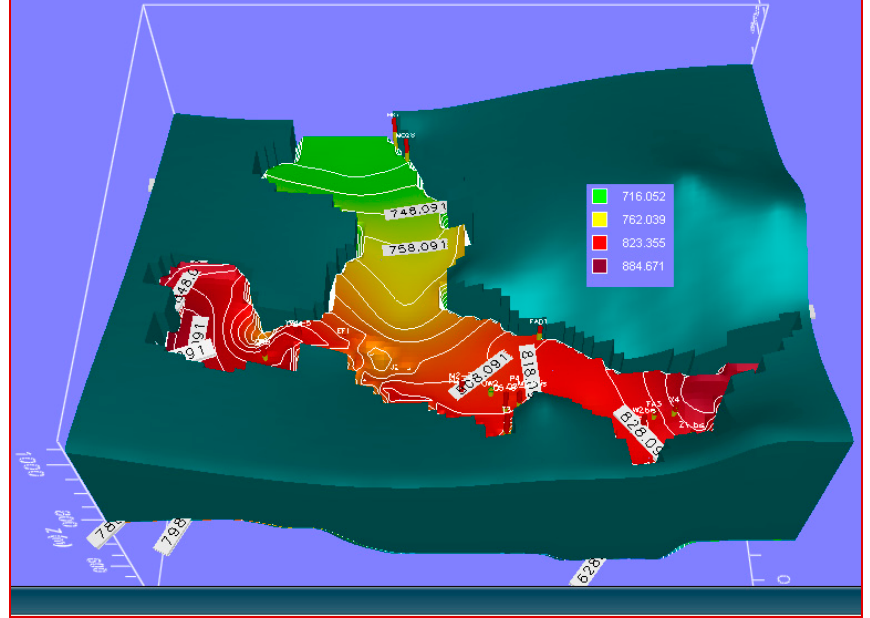
Figure 8. Groundwater flow map for transient simulation in the case of the second scenario.